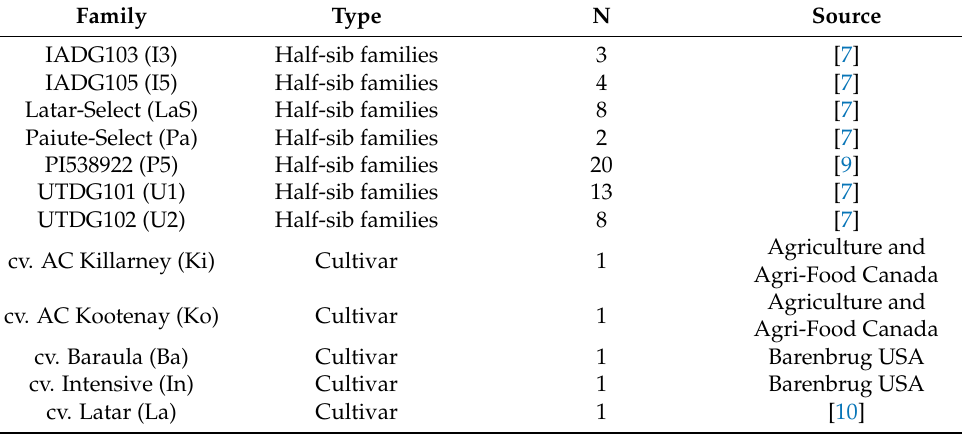
Table 1. Fifty-eight Dactylis glomerata half-sib family source populations and five commercial cultivars, including number (N) or families corresponding to each population and